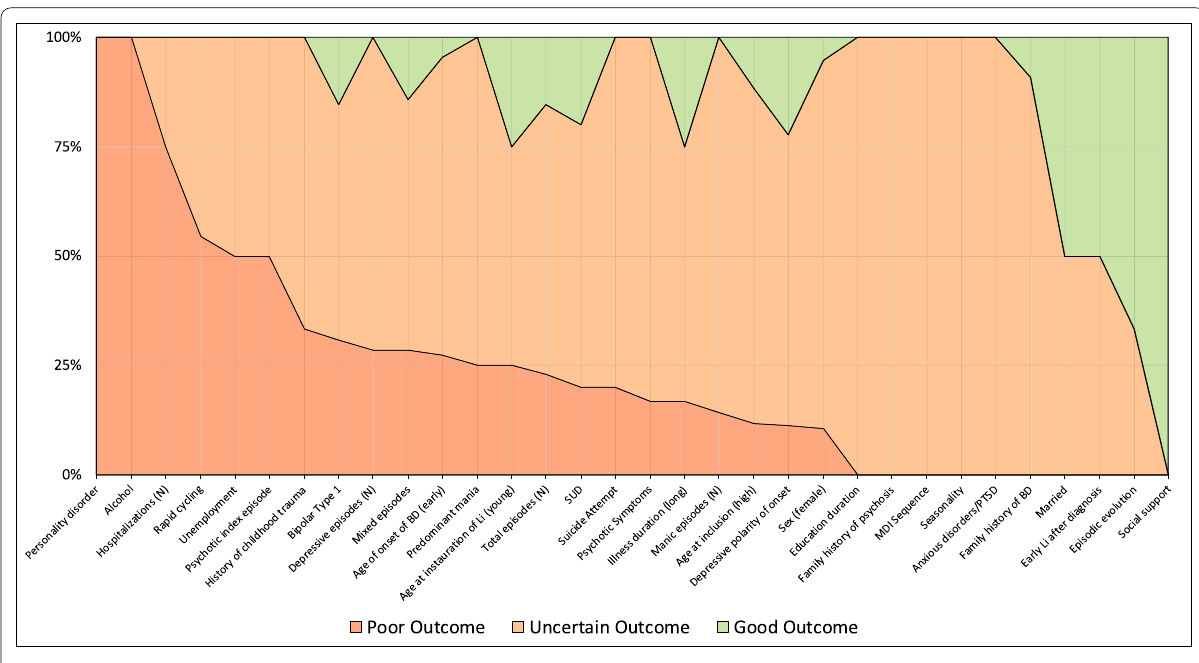
Fig. 2 Diagram graph of all potential predictors being studied in at least 2